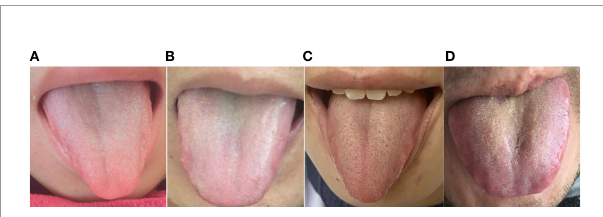
FIGURE 2 | Images of the two groups. (A) Female with an a* value of 7.46 and b* value of 3.65. (B) Male with an a* value of 8.46 and b* value of 3.71. Both (A) and (B) are in the White Coating Group. (C) Female with an a* value of 15.82 and b* value of 10.72. (D) Male with an a* value of 13.83 and b* value of 13.28. Both (C, D) are in the Yellow Coating Group.